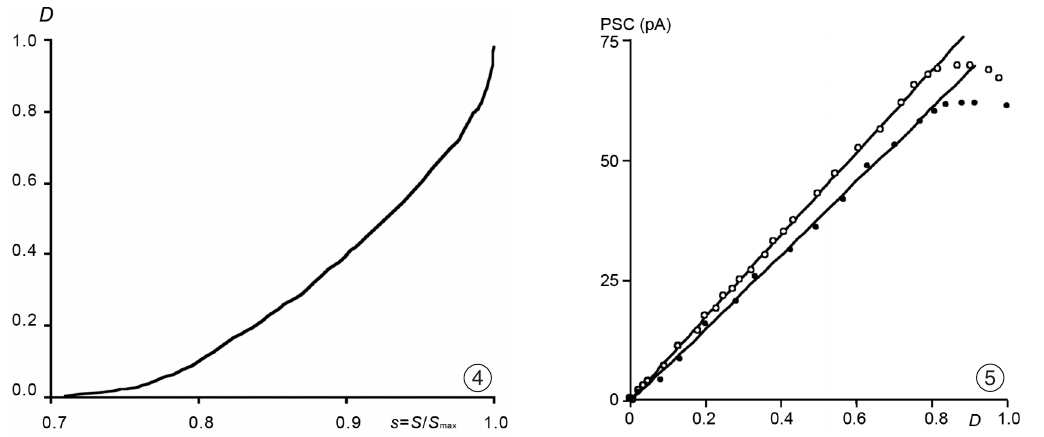
Fig. 4. Variation of the damage parameter, D , with respect to the normalized uniaxial stress, s, applied to a typ- ical marble sample. Fig. 5. PSC with respect to the damage parameter, D , when the sample is under constant stress rate conditions: open circles; PSC with respect to the damage parameter, D , when the sample is under constant deformation rate: solid circles.